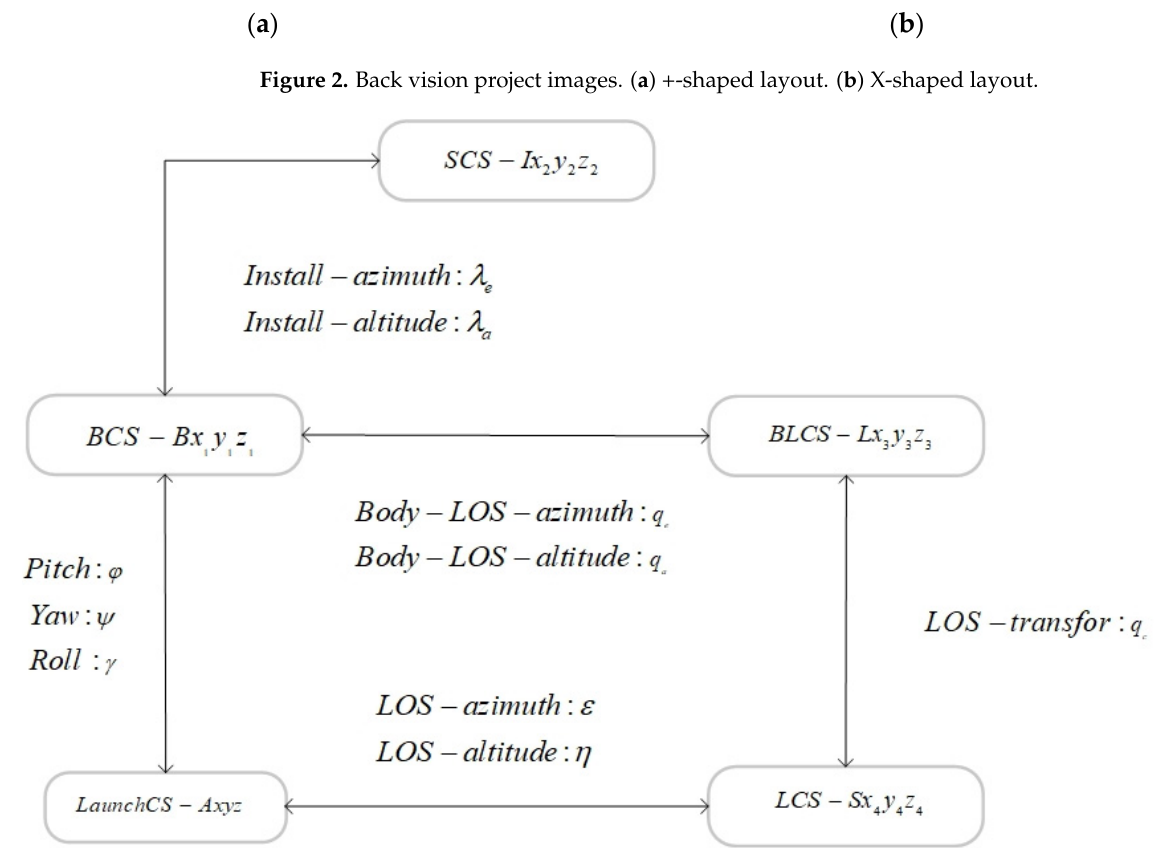
Figure 3. Transformation relationship between coordinate systems.